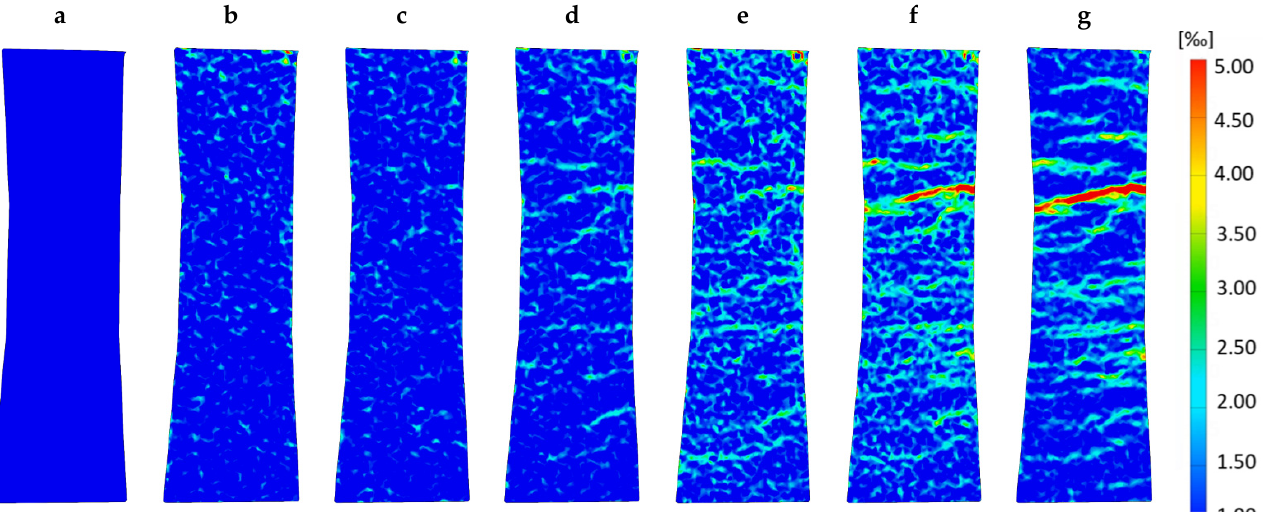
e Figure 14. AE signal’s characteristics, the normalized cumulative sum of AE events and RMS AE . Red circles ( a – g ) indicate the different stages in Figure 13. A small number of AE signals were recorded during the initial linear elastic stage of the loading between points a and c , causing a relatively flat growth of the curve of the normalized cumulative sum of AE events. As can be seen in Figure 13, the AE signals in n o r m a li z e d c u mm u l a t i v